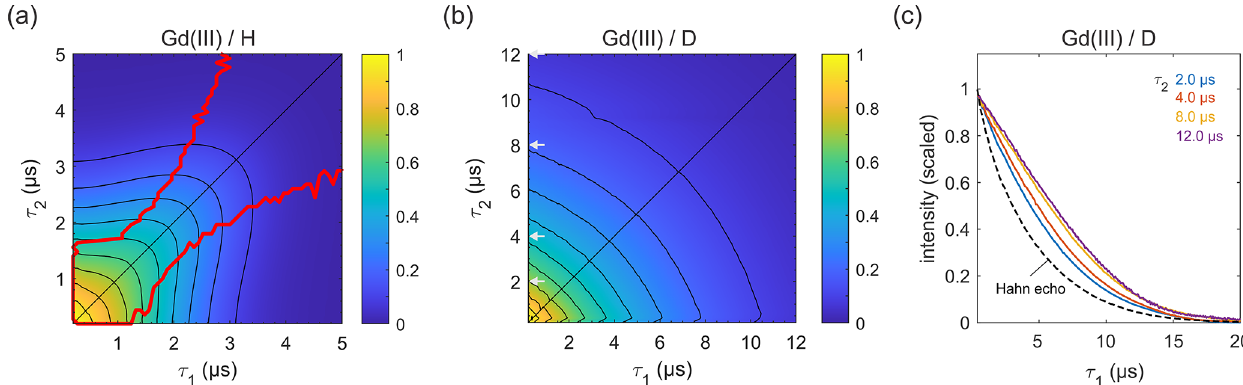
Figure 7. Refocused echo decays for 100µM GdCl 3 in (a) H 2 O / glycerol (80 : 20 v/v ) and (b) D 2 O / glycerol-d 8 at 10K; in panel (a) , the red lines show the position of the echo maximum along τ 1 for each constant τ 2 (upper line) and vice versa (lower line). Grey arrows in (b) indicate the τ 2 values of slices shown in (c) , together with a Hahn echo decay.